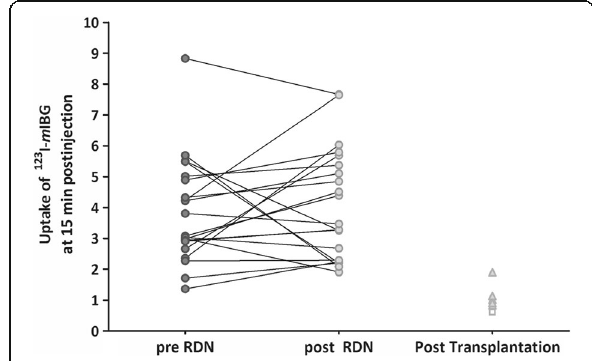
Fig. 2 Change in renal uptake of 123 I – m IBG after RDN. The planar derived mean relative uptake of 123 I – m IBG of the left kidney at 15 min p.i. did not change significantly from pre RDN 3.08 (2.79 – 4.95) to post RDN 3.47 (2.26 – 5.53), p = 0.289. Included on the right